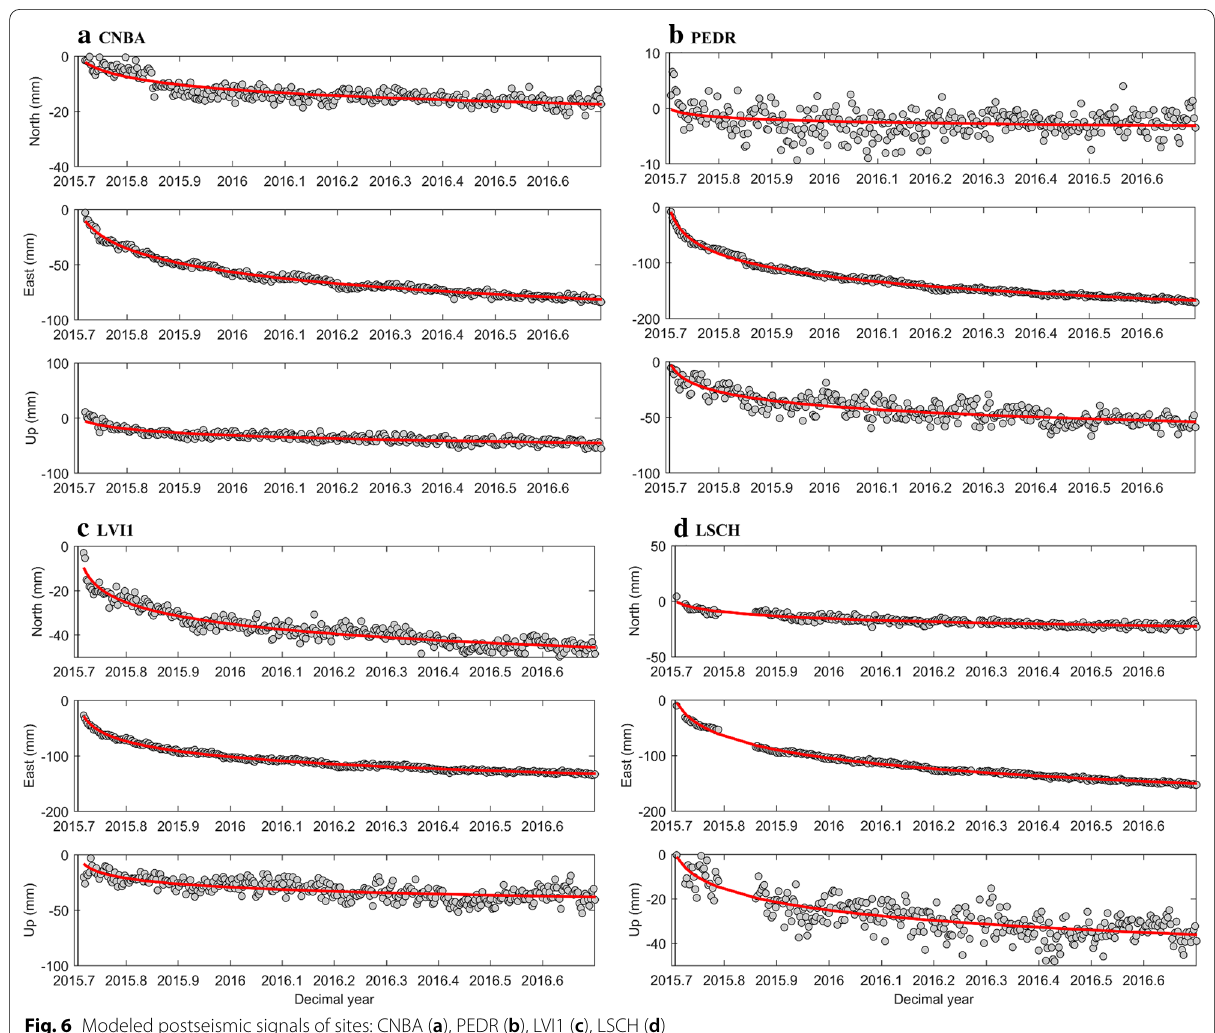
Fig. 6 Modeled postseismic signals of sites: CNBA ( a ), PEDR ( b ), LVI1 ( c ), LSCH ( d